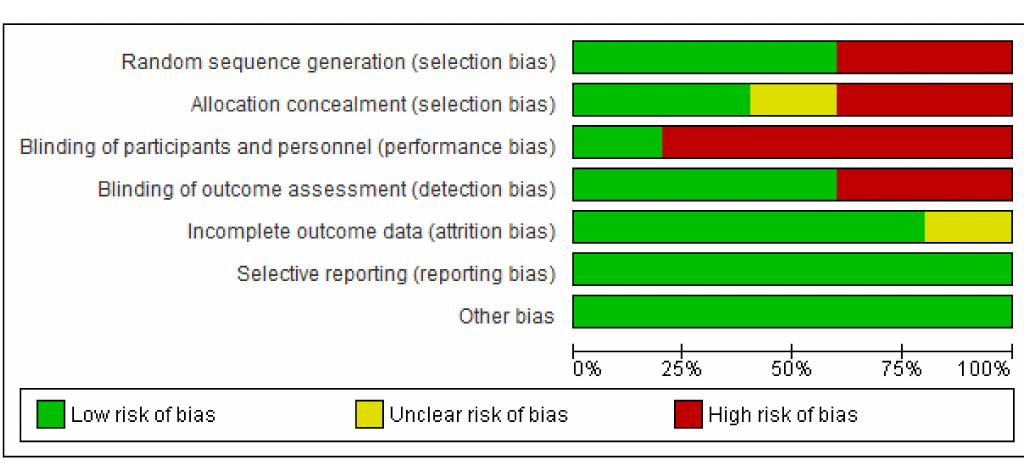
Figure 2. Risk of bias